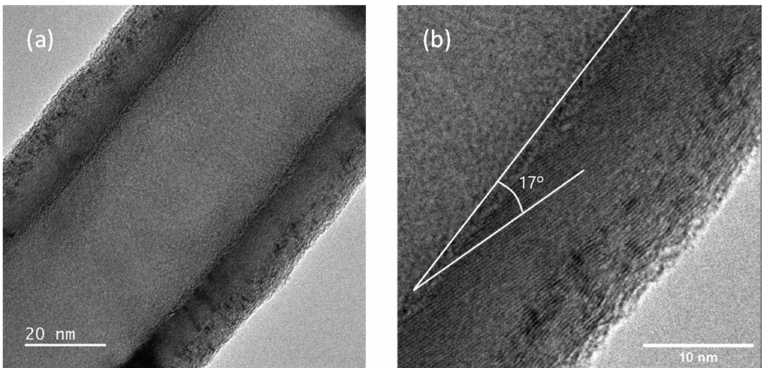
Figure 1. TEM images of vapor grown carbon nanofibres Pyrograf ® -III PR 19 LHT XT, ( a ) hollow core and surrounding layers, ( b ) detail of inner layers constituted of parallel graphene